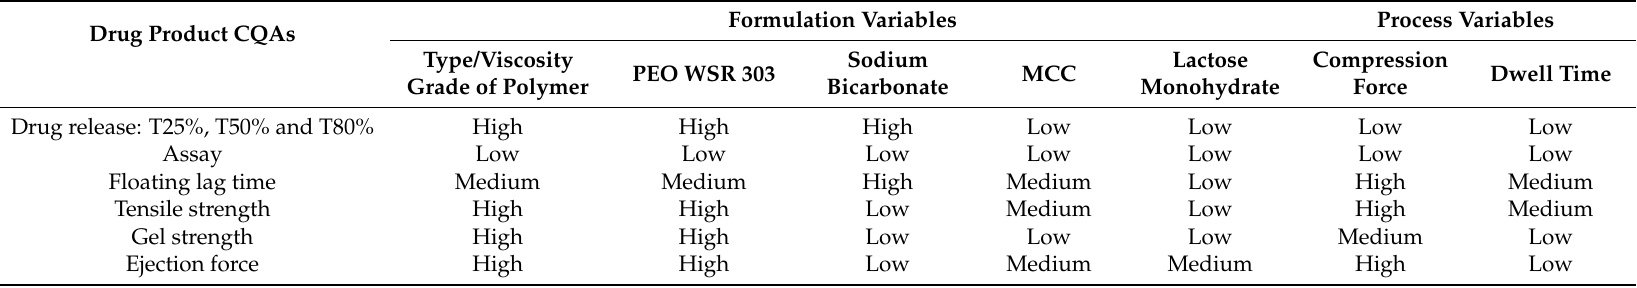
Table 3. Initial risk assessment for formulation and process variables in controlled release effervescent floating